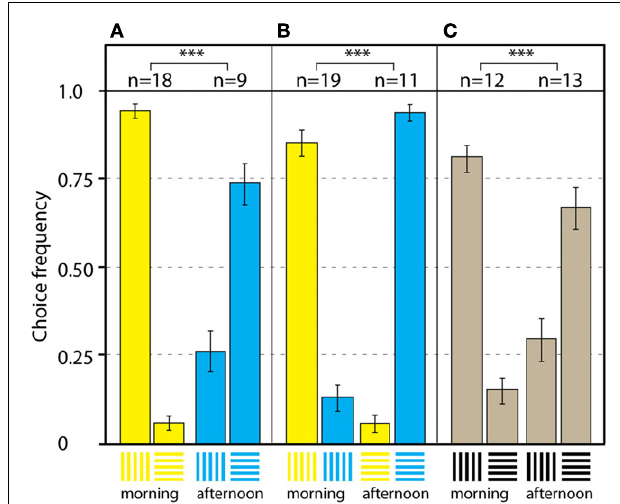
FIGURE 14 |What to do where and when. Results of the transfer tests in the neutral location. (A) Transfer test 2 with yellow and blue training patterns.The bees preferred the yellow vertical stimulus in the morning, and the blue horizontal stimulus in the afternoon. (B) Transfer test 3 with yellow and blue patterns in the same orientation.The bees preferred the yellow stimulus in the morning, and the blue stimulus in the afternoon. (C) Transfer test 4 with black patterns.The bees preferred the vertical grating in the morning, and the horizontal grating in the afternoon. n Denotes number of individual bees in each test; bars are means ± SEM. ***Denotes p < 0.001. Modified from Pahl et al. (2007).